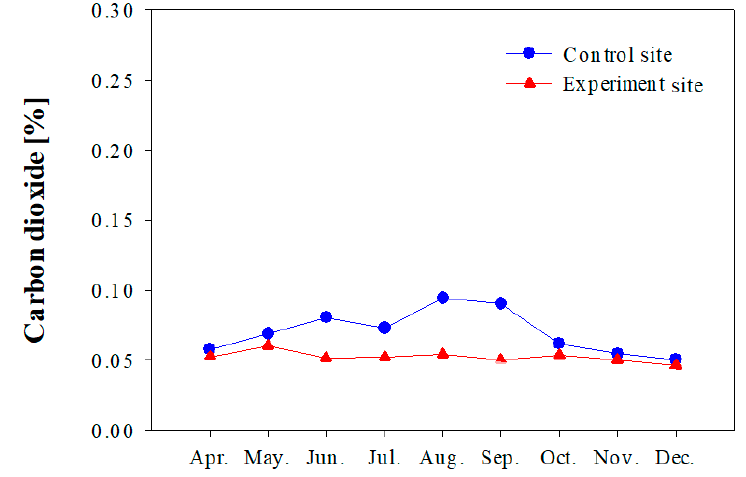
Figure 17. Carbon dioxide level comparison.